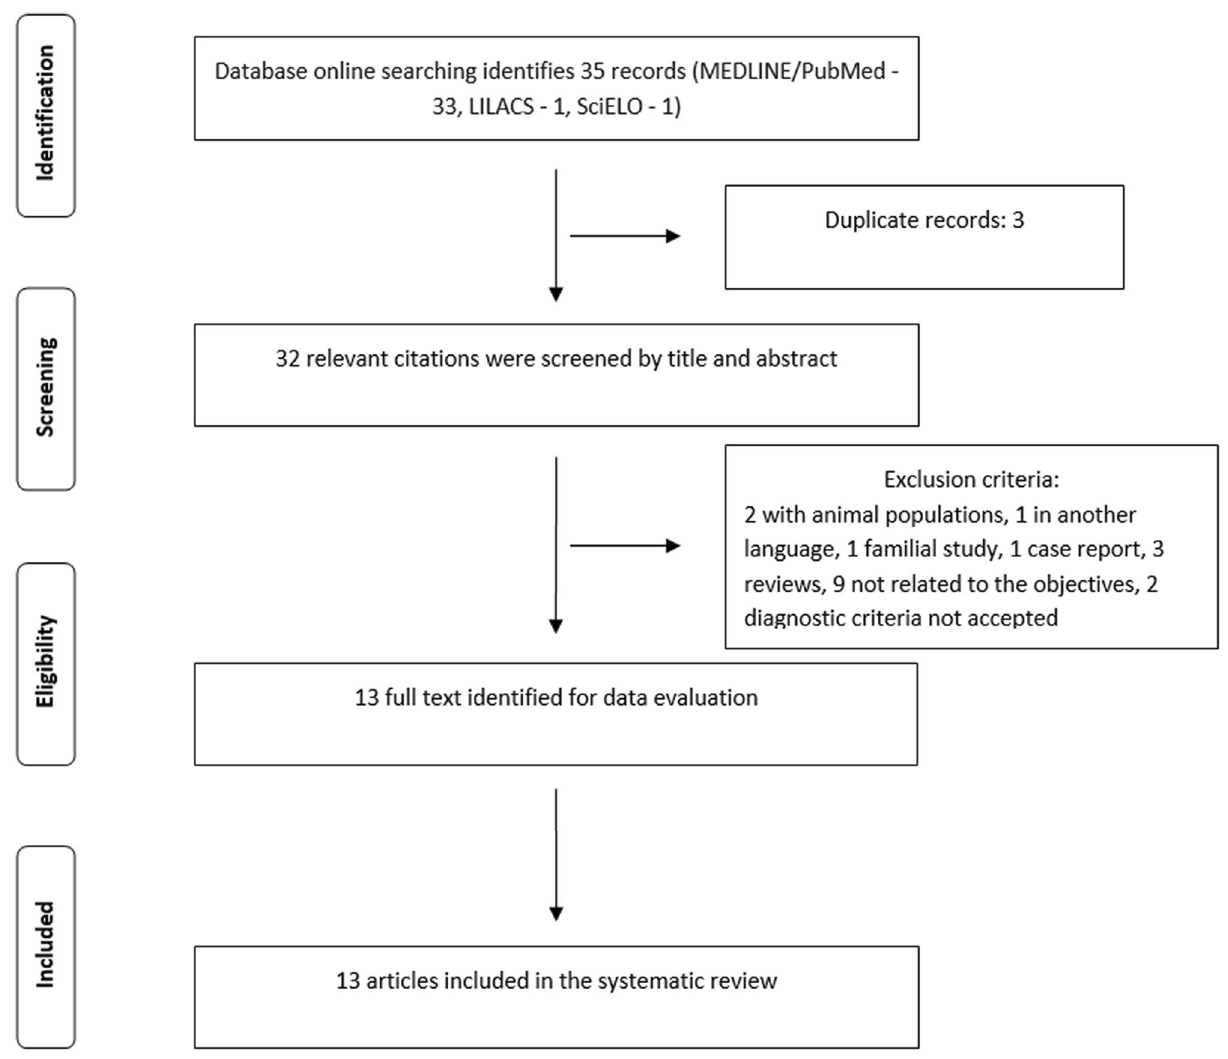
Figure 1. Study identification flowchart. Study identification flowchart following the PRISMA statement 60